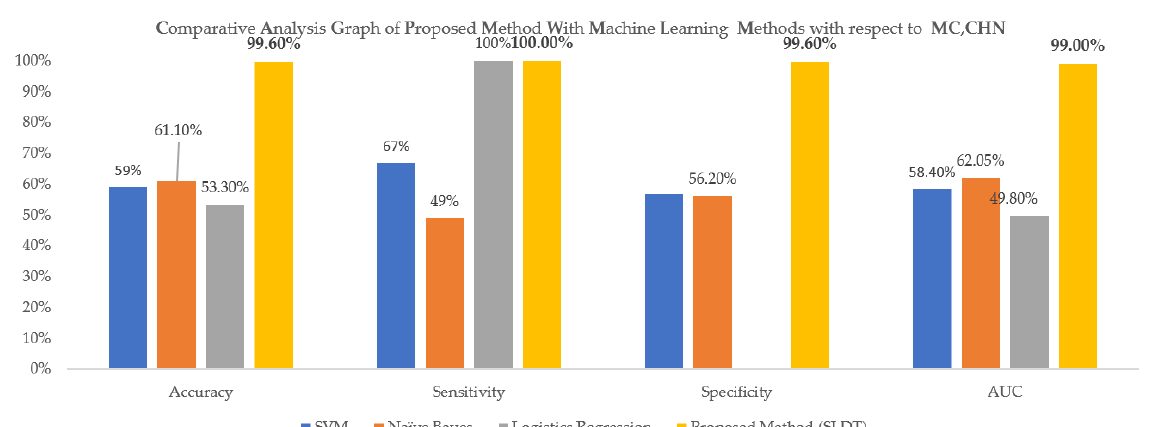
Figure 12. Comparative analysis graph of the proposed method with the machine learning methods with respect to the MC dataset.